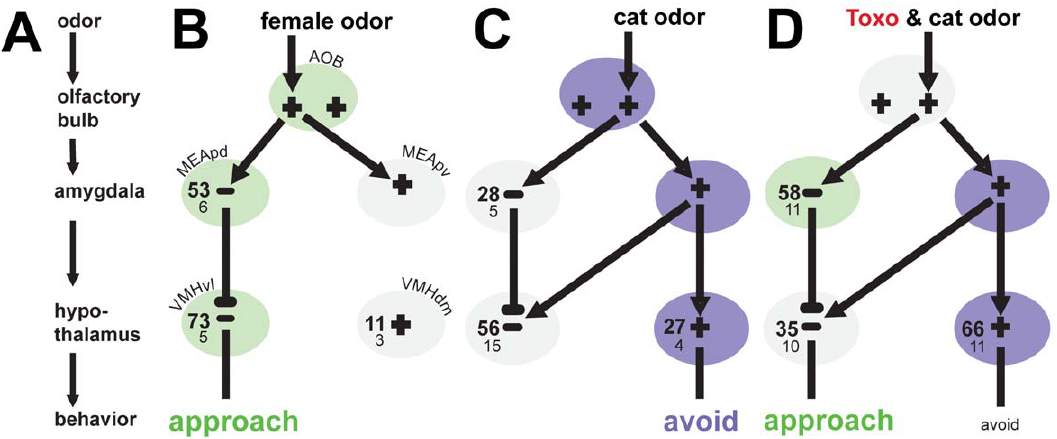
Figure 2. Schematic Model of Toxoplasma Induced Changes to Host Limbic System. (A) General schematic model of limbic brain activity in a male rat after exposure to an emotionally salient odor. (B) Exposure to an inaccessible estrous female activates the ‘reproductive’ pathway, producing robust MEApd activity and evoking approach behavior. (C) Exposure to cat urine activates the ‘defensive’ pathway, producing robust activation of excitatory ( + ) VMHdm neurons and evoking defensive, aversion behavior. Excitatory (pointed arrow) projections from the MEApv activate inhibitory ( 2 ) VMHvl neurons, countering inhibitory (blunted arrow) projections from the MEApd and suppressing any approach behavior. (D) Proposed model for Toxoplasma rats during exposure to cat urine. Robust MEApd activity biases toward approach behavior. Aversion behavior remains, but is lessened. Raw density of c-Fos (large print) 6 SEM (small print) activity is given for each region during relevant odor exposure. Model adapted from Choi 2005. AOB , accessory olfactory bulb; MEA , medial amygdala; VMH , ventromedial hypothalamus.